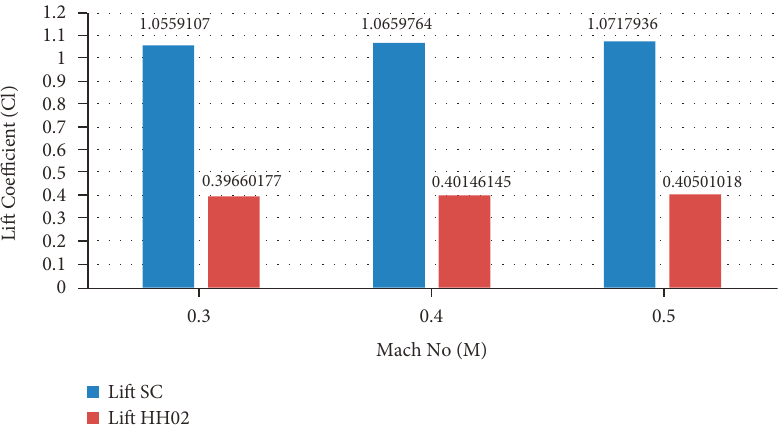
Figure 9: Lift coefficient vs. Mach number.